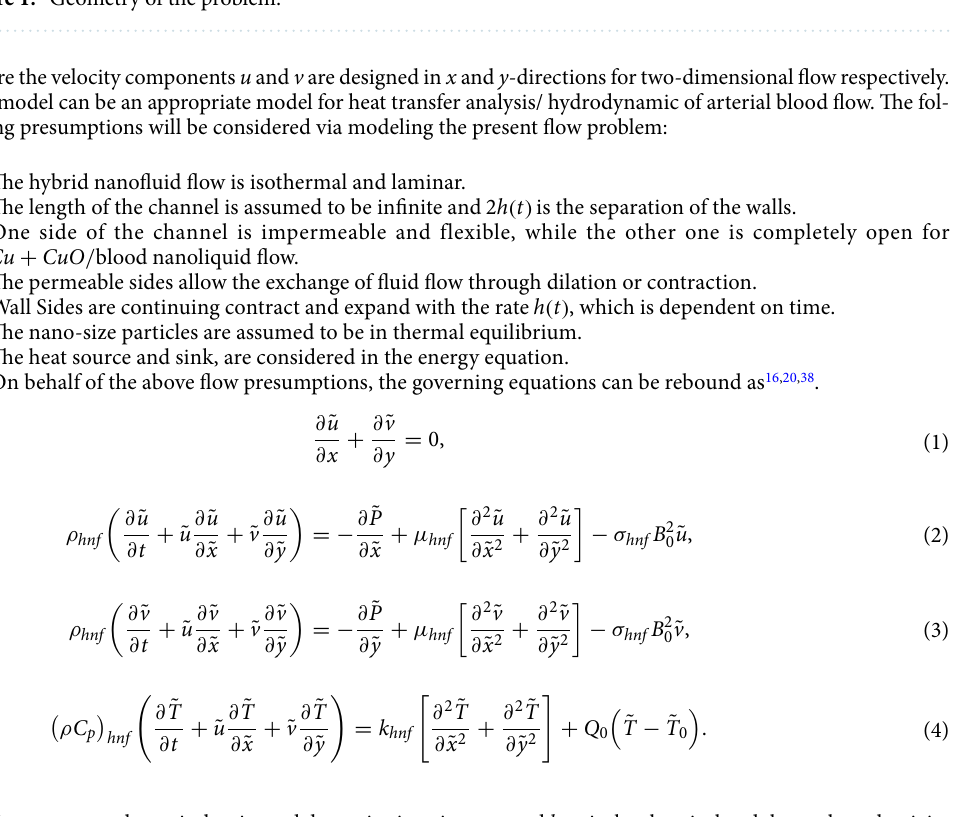
Figure 1. Geometry of the